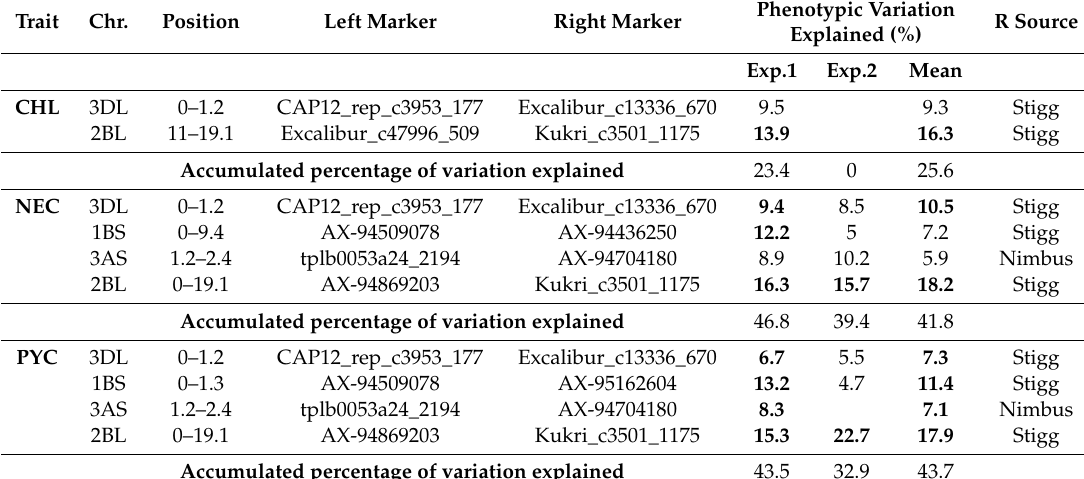
Table 1. QTL for STB related traits in the ‘Nimbus’ x ‘Stigg’ population. QTL are listed if they were over the LOD threshold of 3 (in bold) in at least one environment or over the threshold of 2 in multiple environments. CHL—chlorosis, NEC—necrosis,